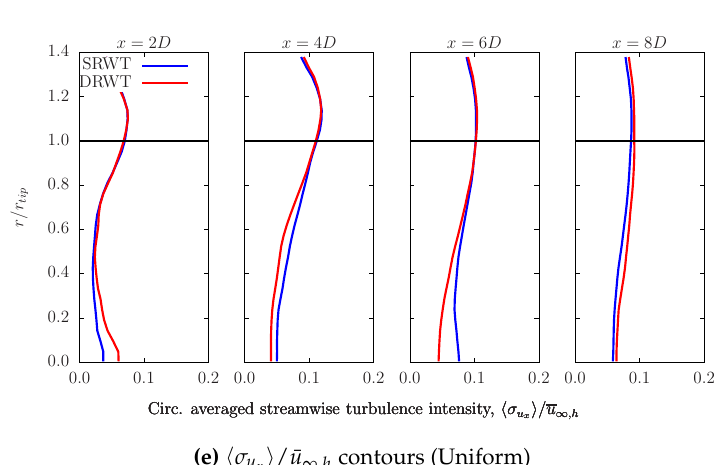
Figure 11. Comparison between SRWT and DRWT of normalized streamwise turbulence intensity, σ u / ¯ u ∞ , h : ( a , b ) on the x - z plane passing through the rotor hub; ( c , d ) on cross-stream ( y - z ) planes; and x ( e ) circumferentially averaged values at four downstream locations ( x / D = 2, 4, 6, and 8) for the uniform inflow